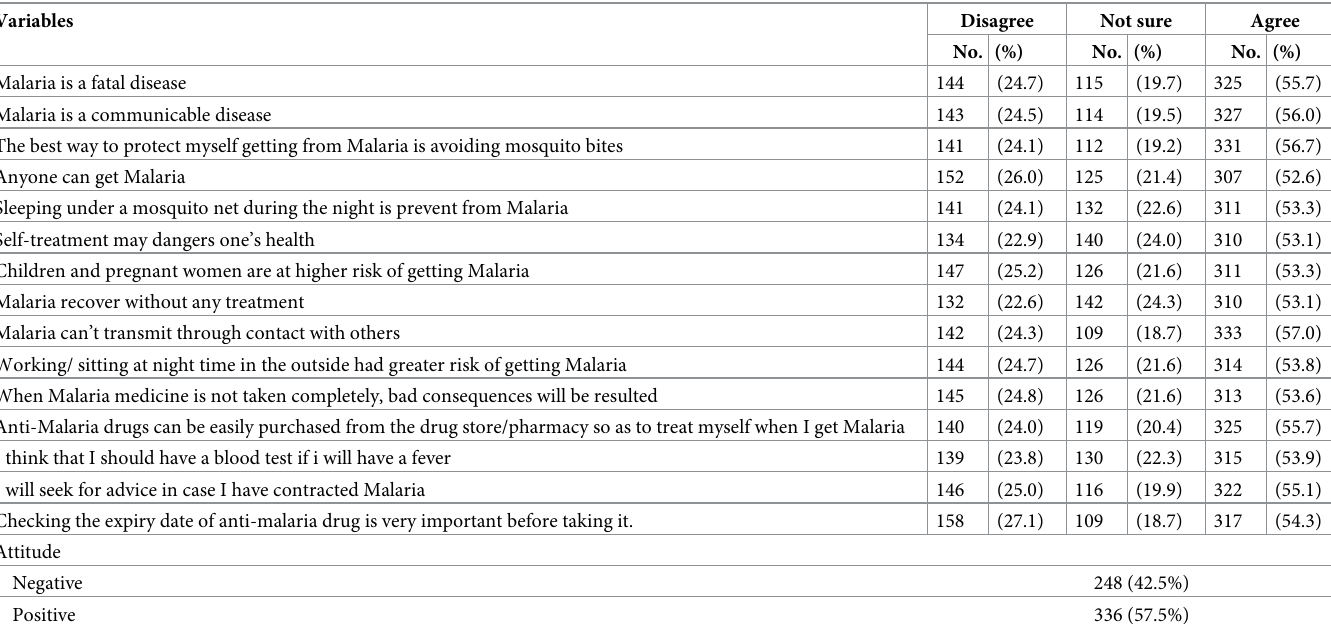
Table 3. Attitude towards malaria prevention and control among households in Hawassa City, South Ethiopia, 2020. Variables